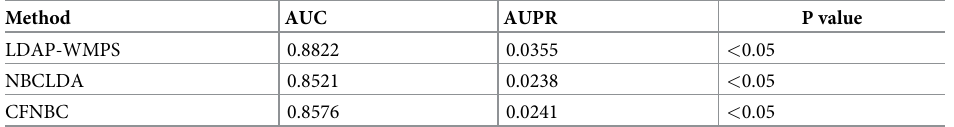
Table 1. AUC values of LDAP-WMPS model and other models under LOOCV framework under the same dataset.